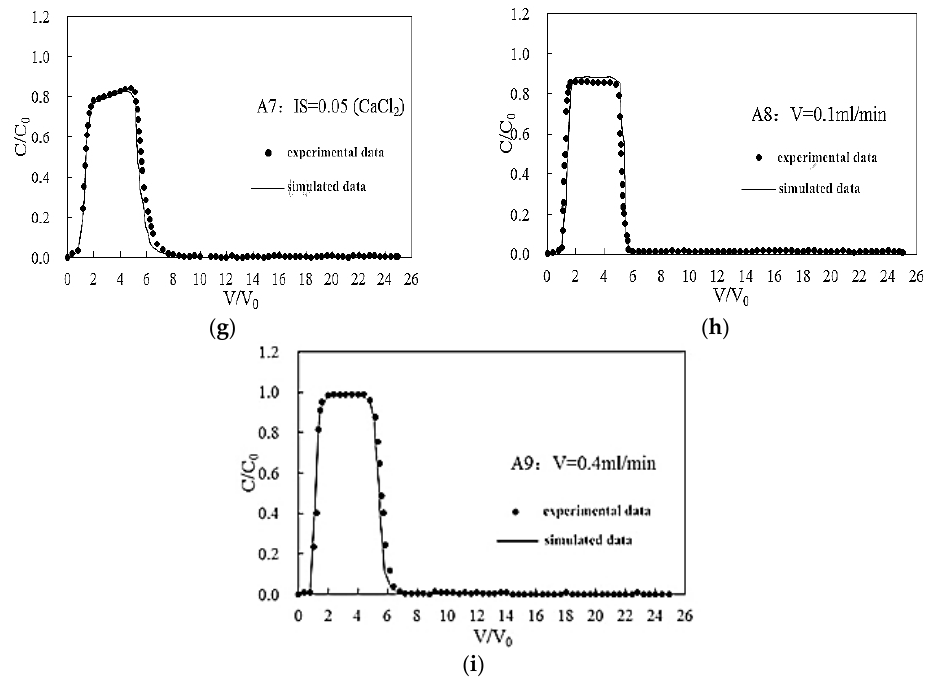
Figure 7. Experimental simulation curves. ( a ) A1 group experimental simulation curve; ( b ) A2 group experimental simulation curve; ( c ) A3 group experimental simulation curve; ( d ) A4 group experimental simulation curve; ( e ) A5 group experimental simulation curve; ( f ) A6 group experimental simulation curve; ( g ) A7 group experimental simulation curve; ( h ) A8 group experimental simulation curve; ( i ) A9 group experimental simulation curve.